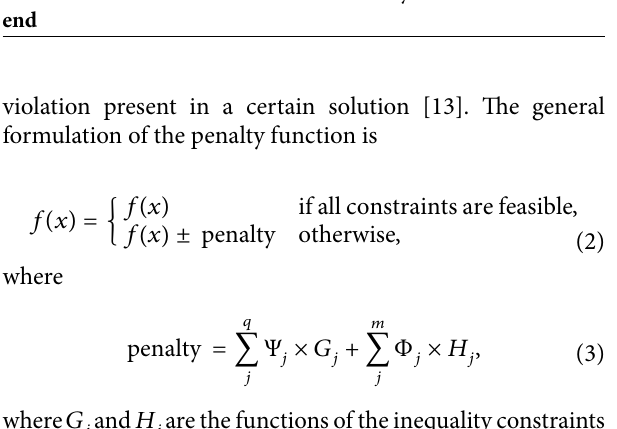
if (no constraint violation or rank based on the objective value